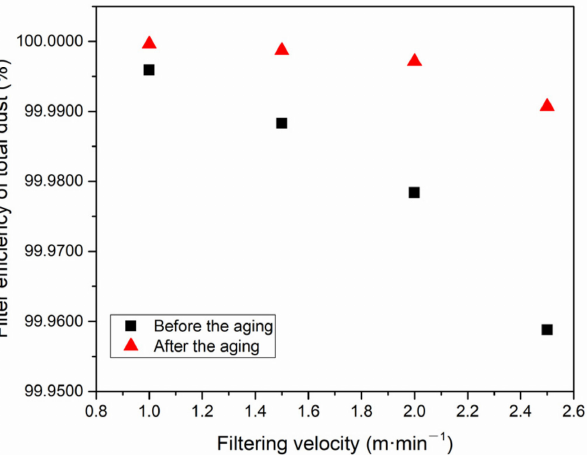
Figure 9. Filtration efficiency of filter media for total dust at different filtering velocities.